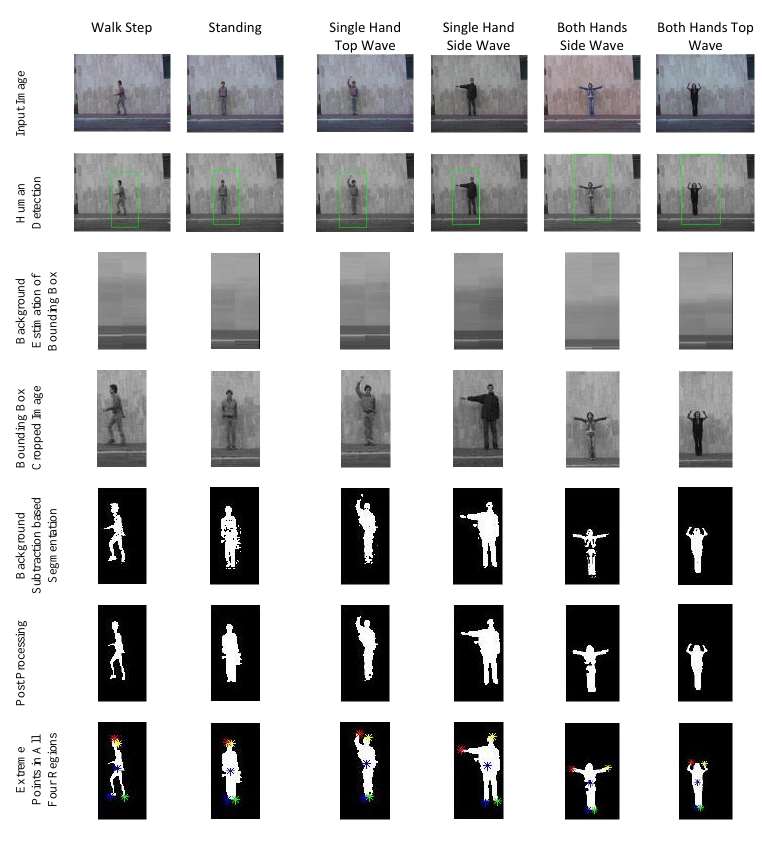
Figure 5. Results of each step through the proposed ndjndjm